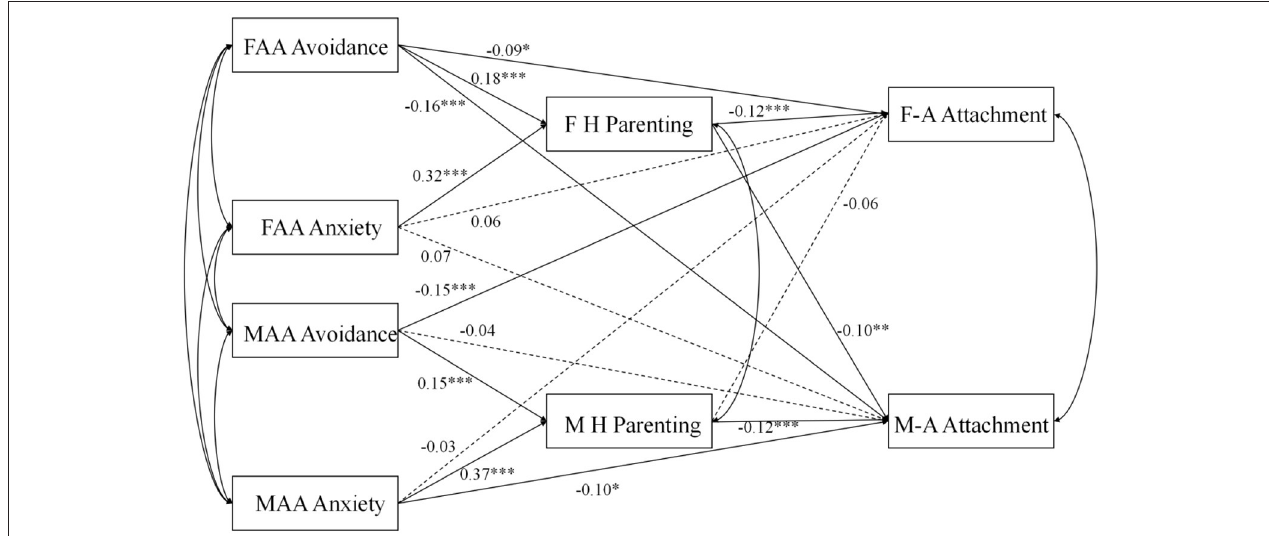
FIGURE 3 | Structural equation model. FAA Avoidance, father adult attachment avoidance; FAA Anxiety, father adult attachment anxiety; MAA Avoidance, mother adult attachment avoidance; MAA Anxiety, mother adult attachment anxiety; F H parenting, father harsh parenting; M H parenting, mother harsh parenting; F-A Attachment, father-adolescent attachment; M-A Attachment, mother-adolescent attachment. * P < 0.05. ** P < 0.01. *** P <